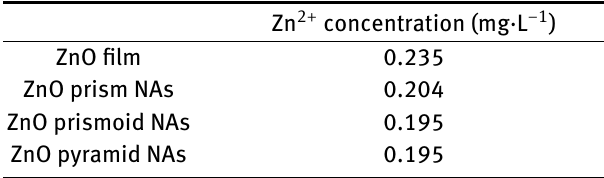
Table S3: Atomic absorption spectrometry results of Zn 2+ leaching out from ZnO film and three ZnO